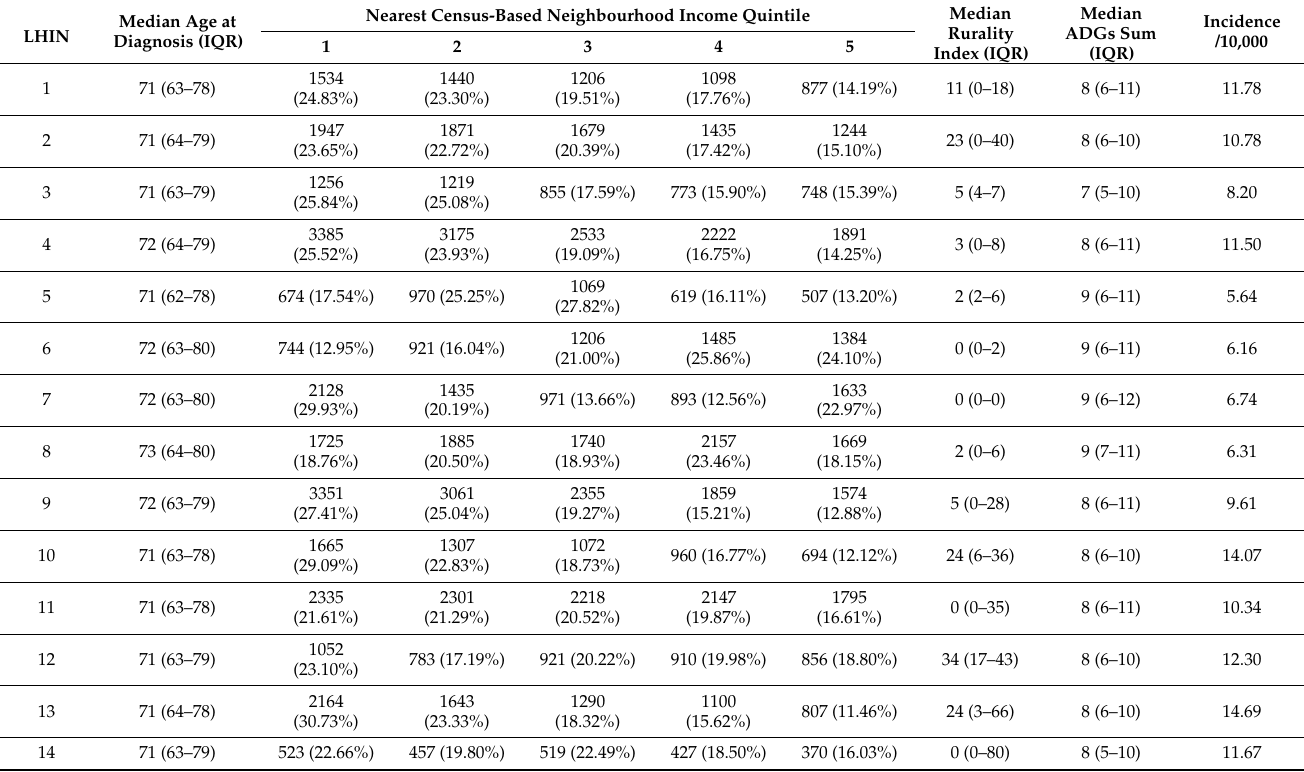
Table 3. Patient characteristics stratified by